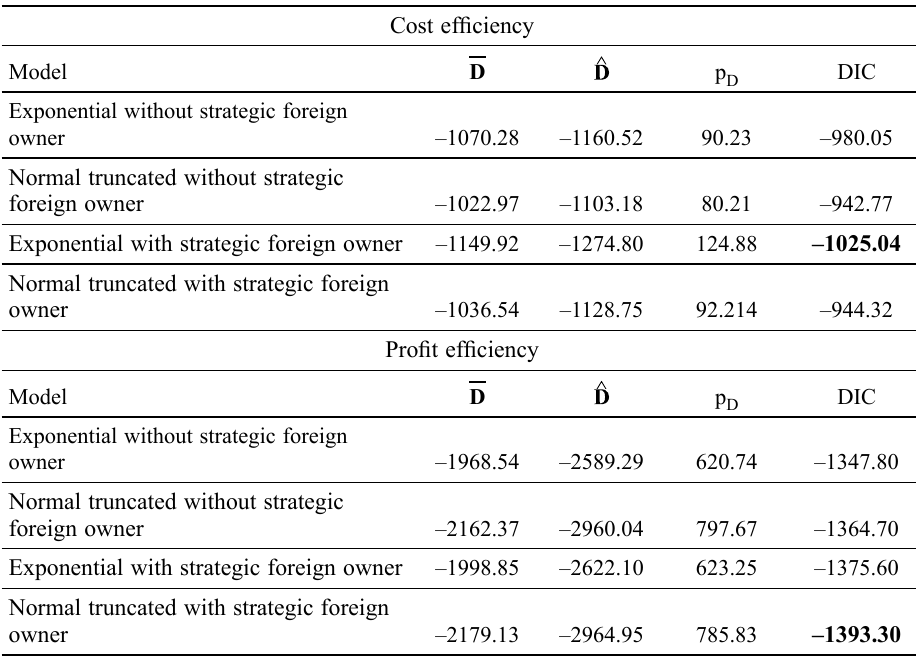
Table 7. Comparison of models which use the ownership form as an explanatory covariate of the inefficiency term distribution (in bold signalled the model with the best goodness of fit to